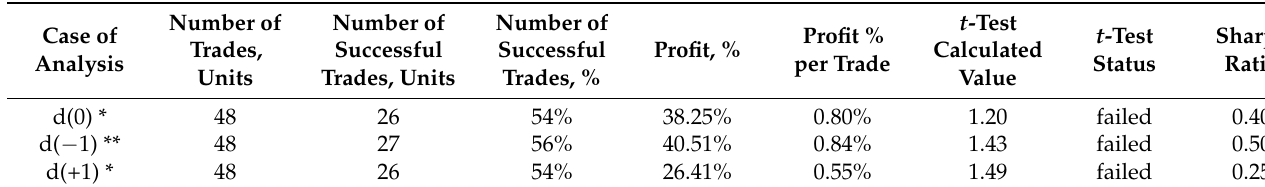
Table 2. Trading simulation results of the expiration day price effects: daily data.